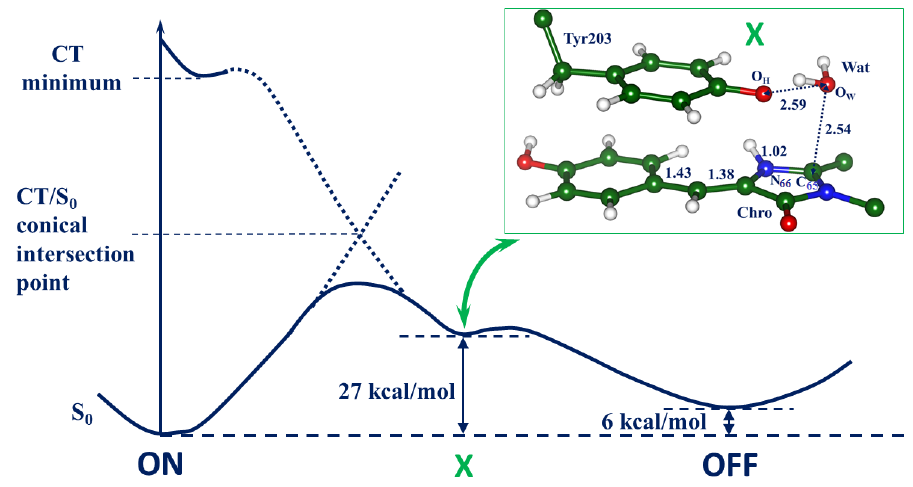
Figure 6. The summary energy diagram and the structure of the ground-state reaction intermediate X (inset). The interatomic distances are given in Å. Energies of the ground-state structures ON, X, and OFF are computed at the QM/MM level.